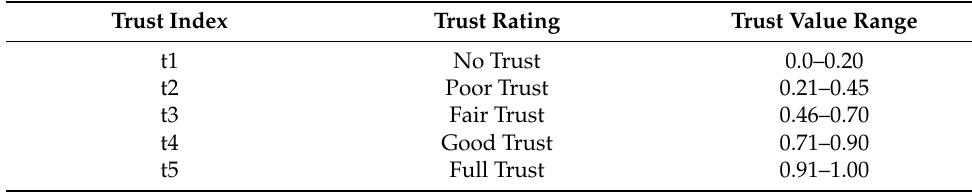
Table 3. Five-Tuple Trust